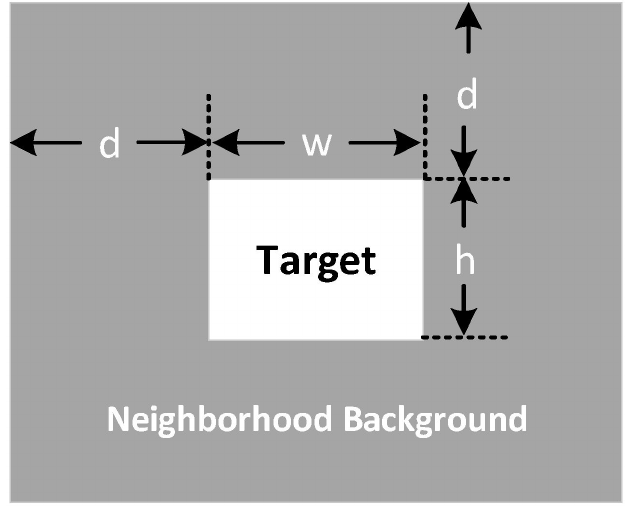
Figure 6. Small target and its neighborhood